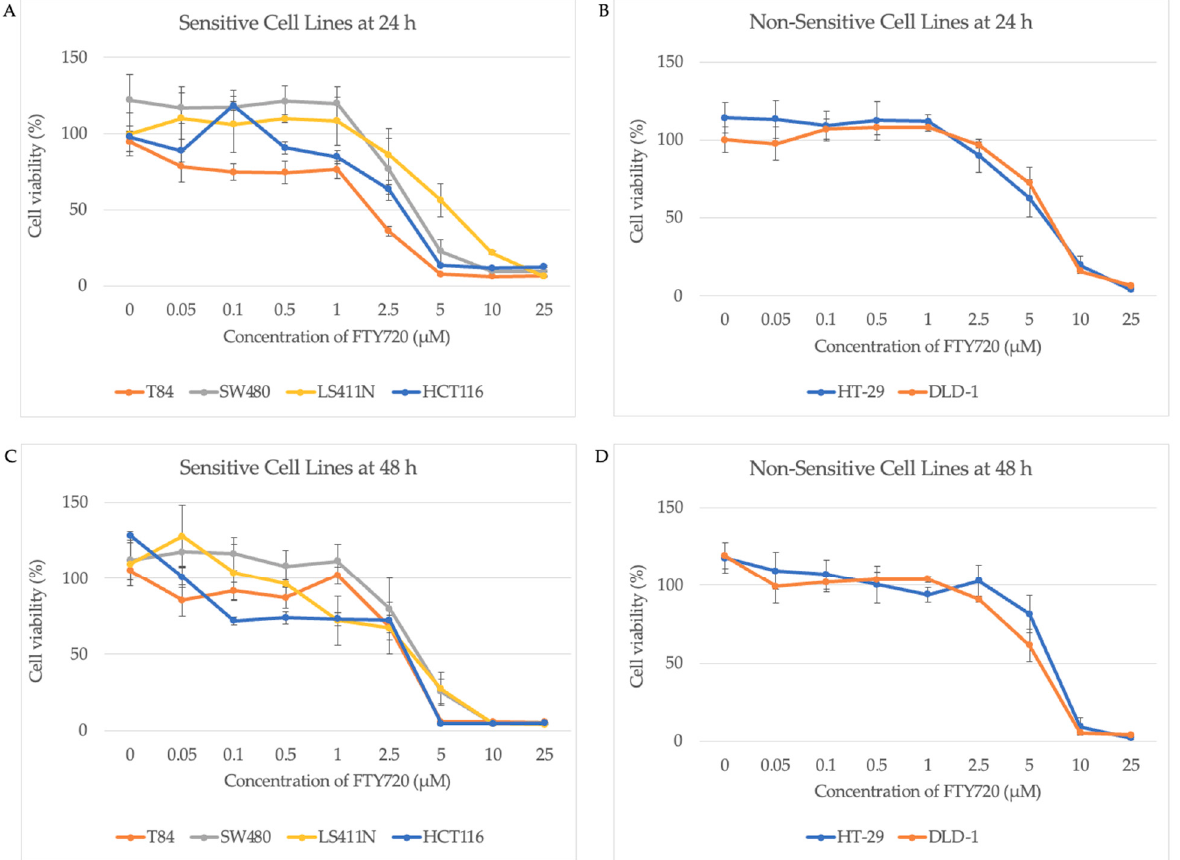
Figure 2. Line graphs of the cell viability assays. The cell viability of the cell lines at each dose of FTY720 is expressed as a percentage of the vehicle control. Data at 0 μ M represent incubation of the cell lines in the medium without the vehicle (dimethyl sulfoxide (DMSO)). Error bars represent the standard deviation from three experimental replicates, each with three analytical repeats. ( A ) Sensitive colorectal cancer (CRC) cell lines at 24 h. ( B ) Non-sensitive CRC cell lines at 24 h. ( C ) Sensitive CRC cell lines at 48 h. ( D ) Non-sensitive CRC cell lines at 48 h.